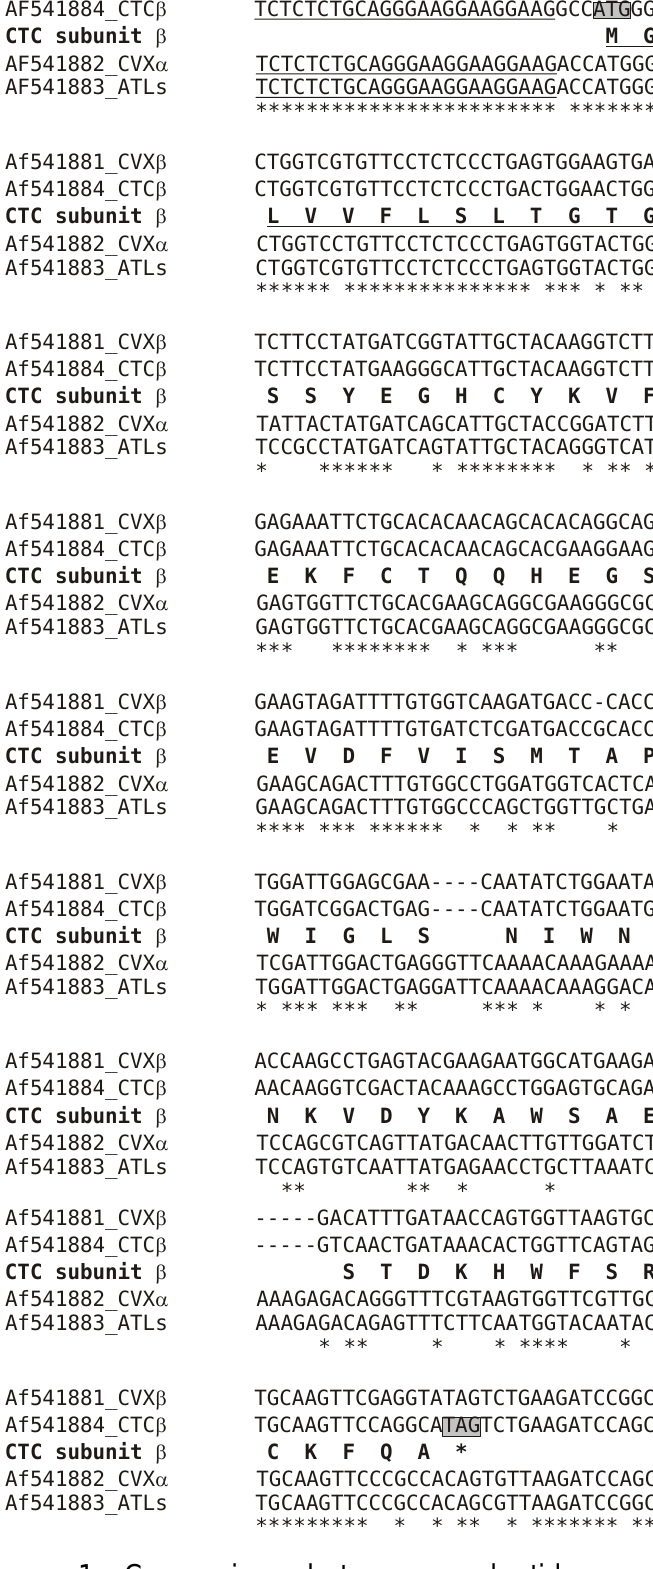
Figure 1: Comparison between nucleotide sequences of crotacetin subunit β , convulxin subunits α and β , and anti-thrombin-like subunit